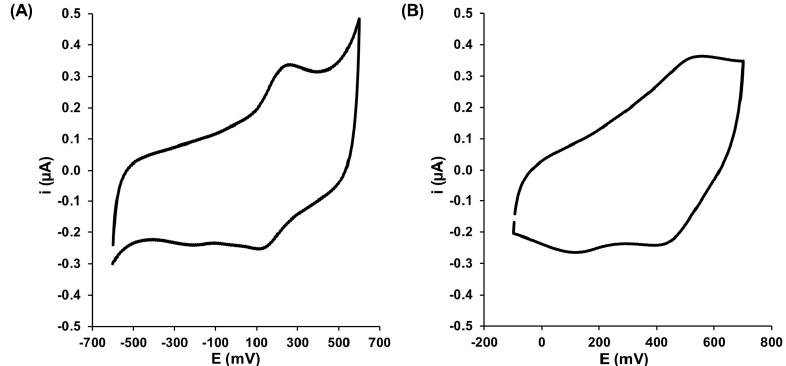
Figure 5. Cyclic voltammogram recorded with electrode Au-SCX-COOH/MET–DA in the blank solution ( A ) PBS buffer pH 7.4 or ( B ) 0.2 M McIlvain pH 2.0.